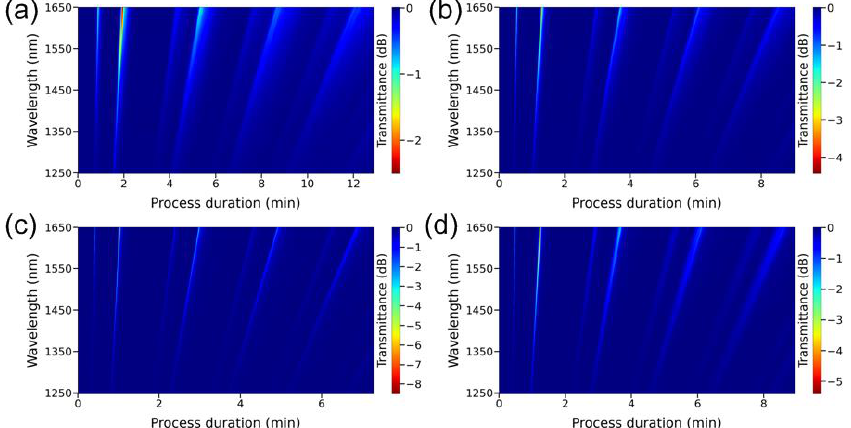
Figure 6. Dependence of the spectral response on the deposition process duration in the wavelength range from 1250 to 1650 nm. The etched region of the optical fiber was located at a distance of ( a ) 0 mm, ( b ) 6 mm, ( c ) 14 mm, and ( d ) 20 mm from the furnace center.